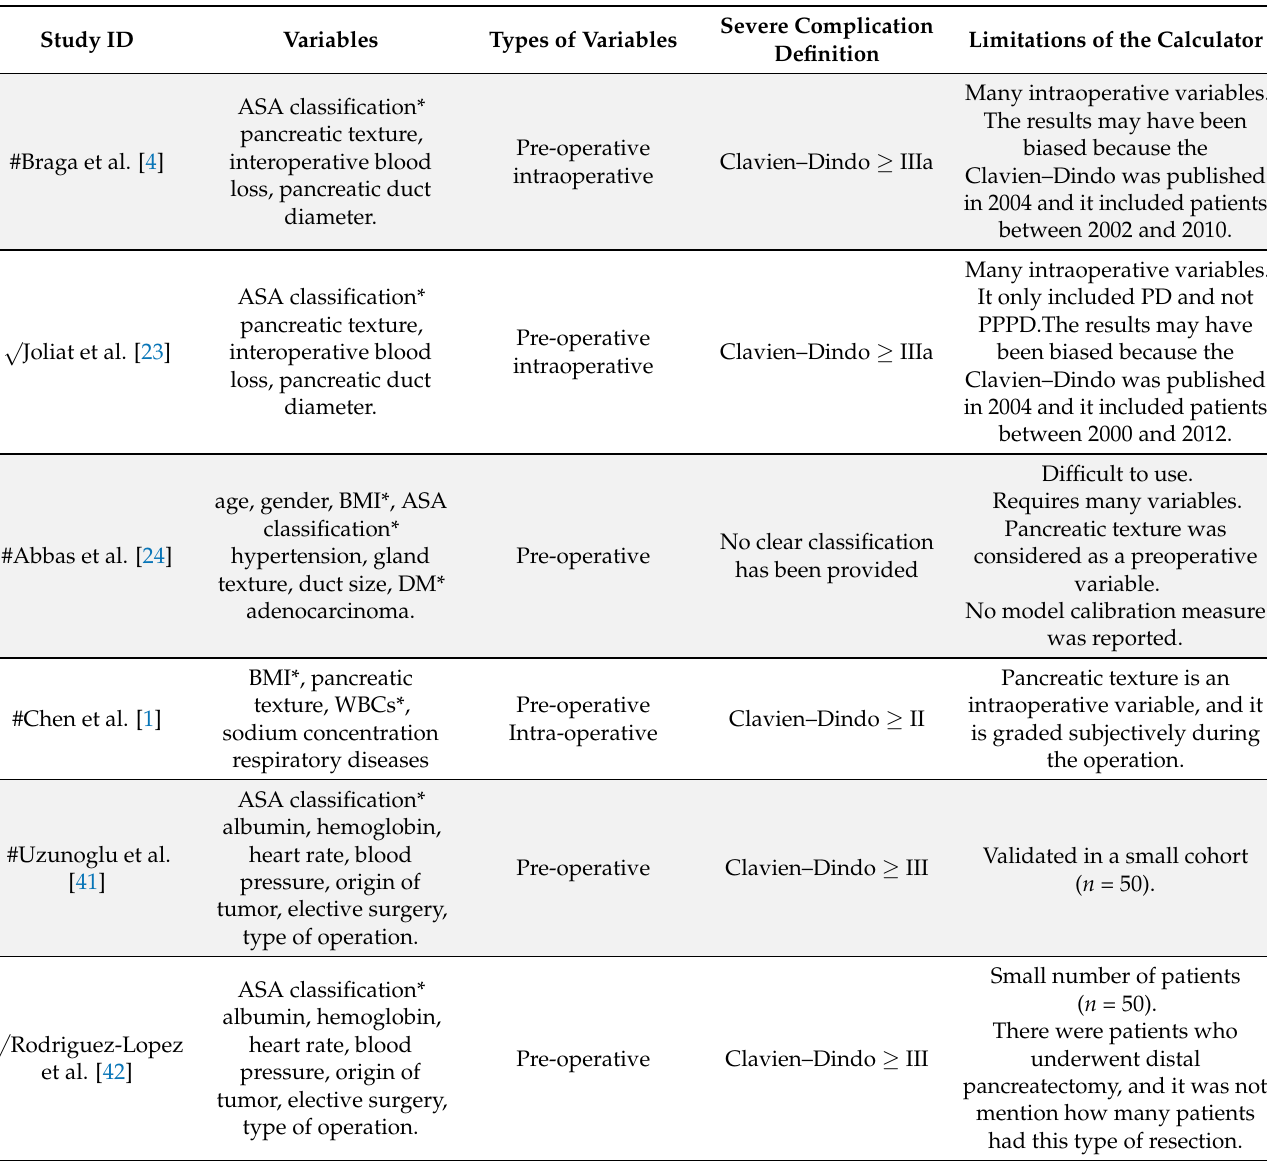
Table 3. A summary of the established risk calculators focusing on postoperative severe complications following